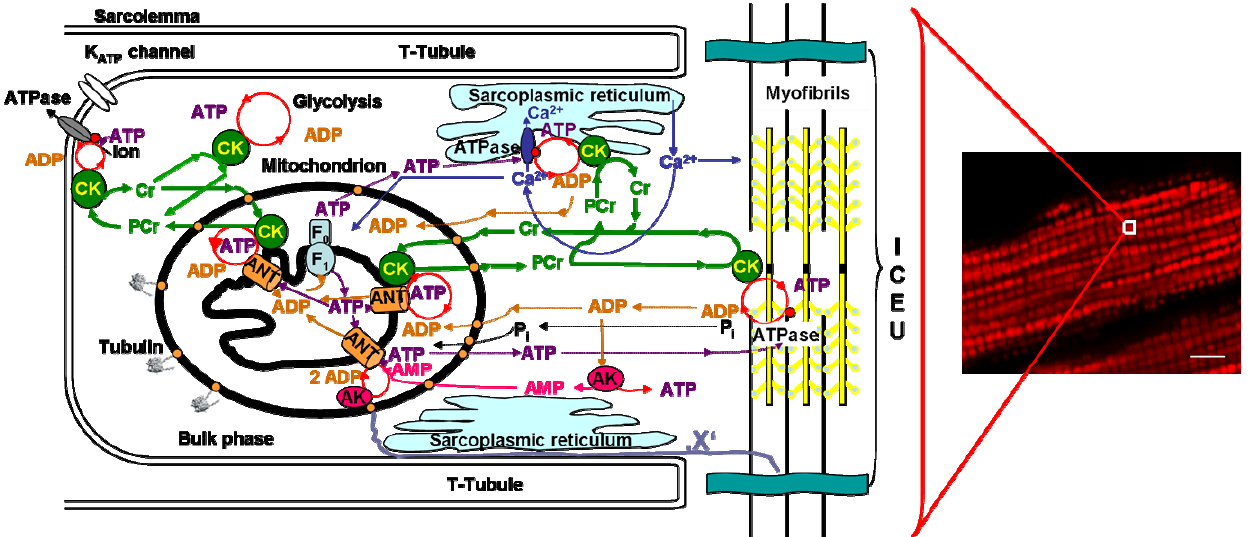
Figure 4. Organization of compartmentalized energy transfer and metabolism in cardiac cells by intracellular energetic units (ICEU). Adapted from ref.